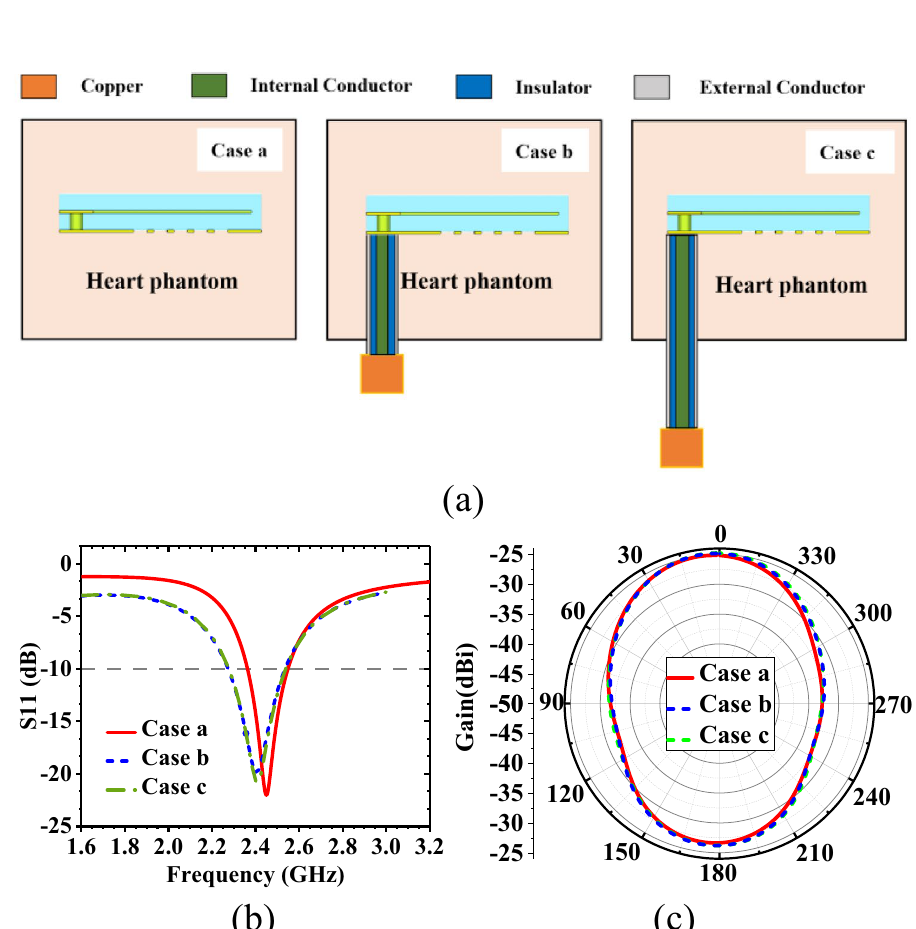
Figure 9. Coaxial cable effects on the antenna performance (f = 2.45 GHz). ( a ) Model in different cases. ( b ) S11 of antennas in different cases. ( c ) Radiation patterns of antennas in different